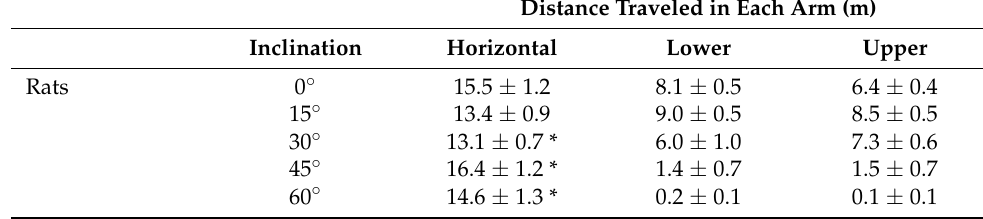
Table 4. The mean ( ± SEM) of the distance traveled along each arm by each species at each inclination. Results of the ANOVA are depicted below the means, demonstrating a significant effect of arm, inclination, and species, as well as significance in all interactions among these factors. * indicates that the distance traveled along the horizontal arm at this level is significantly greater than the distance traveled along both the upper and lower arms (HSD test for unequal